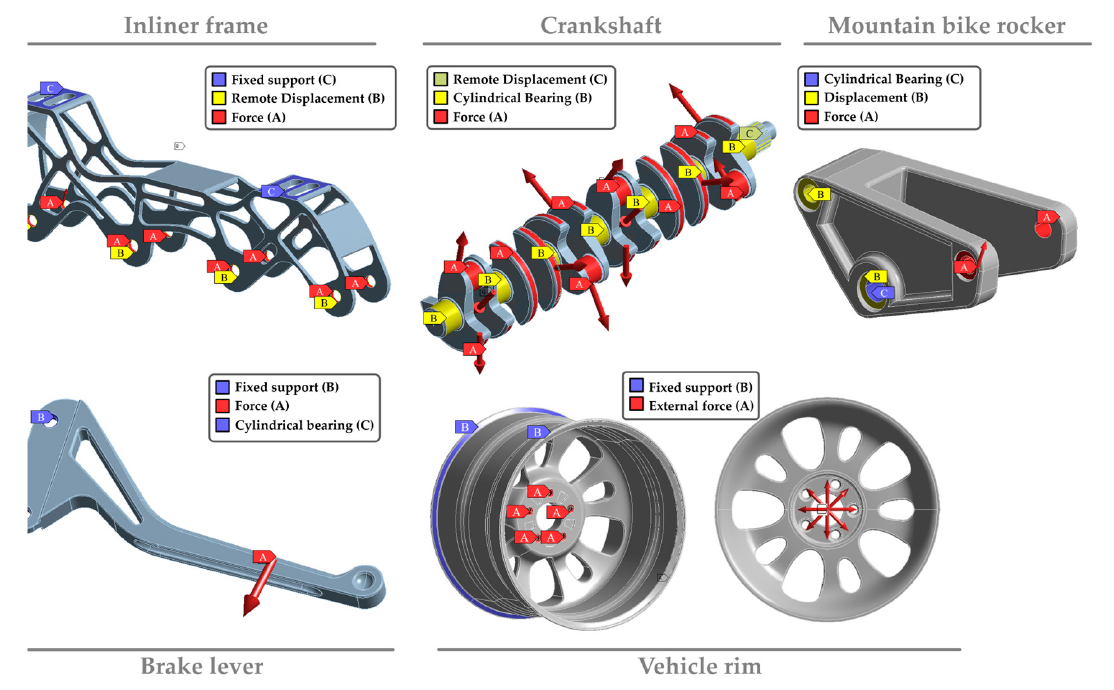
Figure 7. Overview of the different simulation setups.